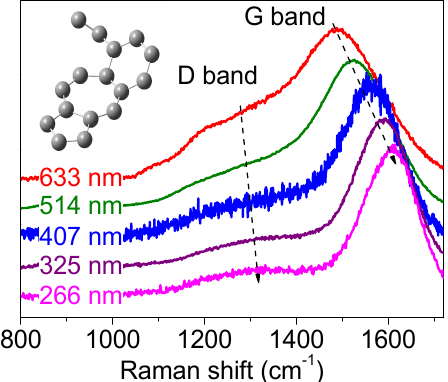
Figure 22. Raman spectra of amorphous carbon (a ‐ C:H with about 30 at.% H) obtained with different laser wavelengths.